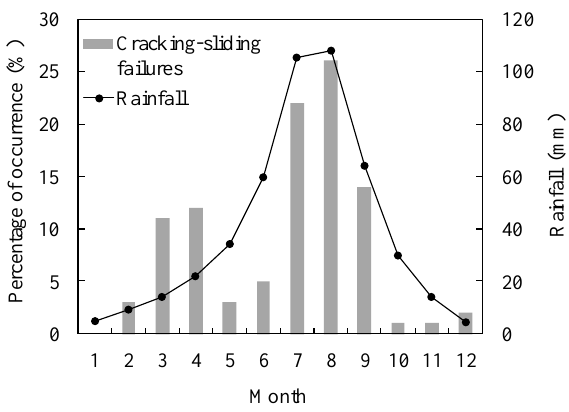
Figure 6. Occurrence of cracking–sliding failures mainly in July to September and consistent with average monthly